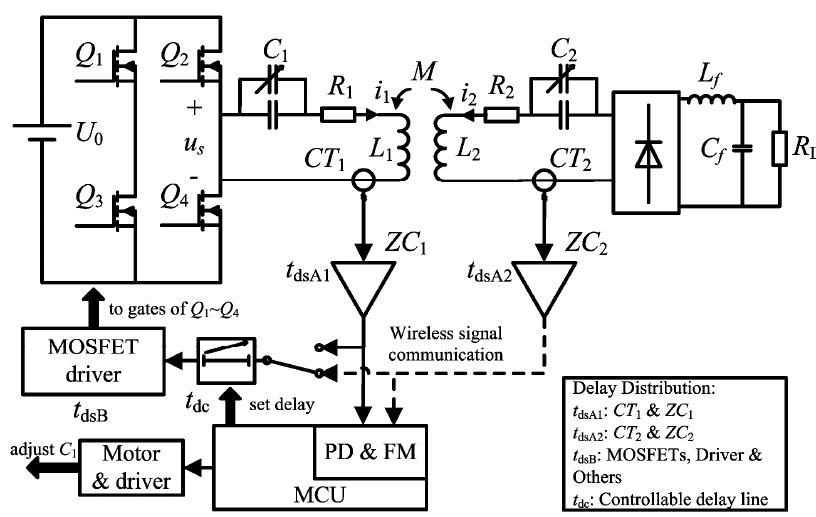
Figure 9. Block diagram of the experimental platform.